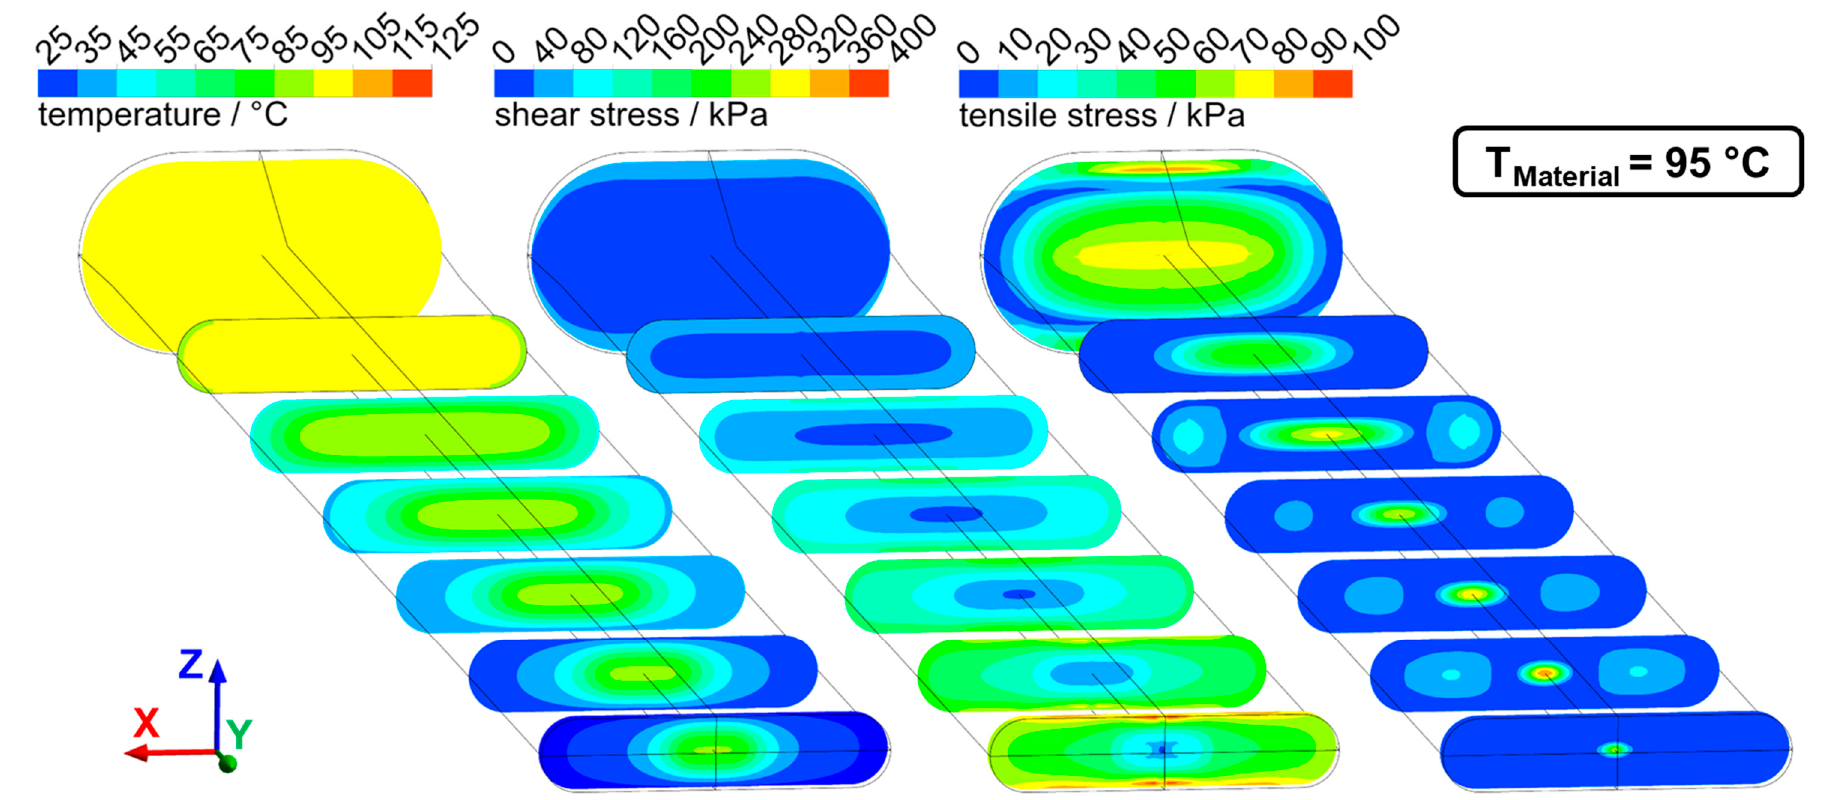
Figure 9. Temperature, shear stress, and tensile stress distribution in the die section at T Material = 95 °C in sectional views transversely to the flow direction.